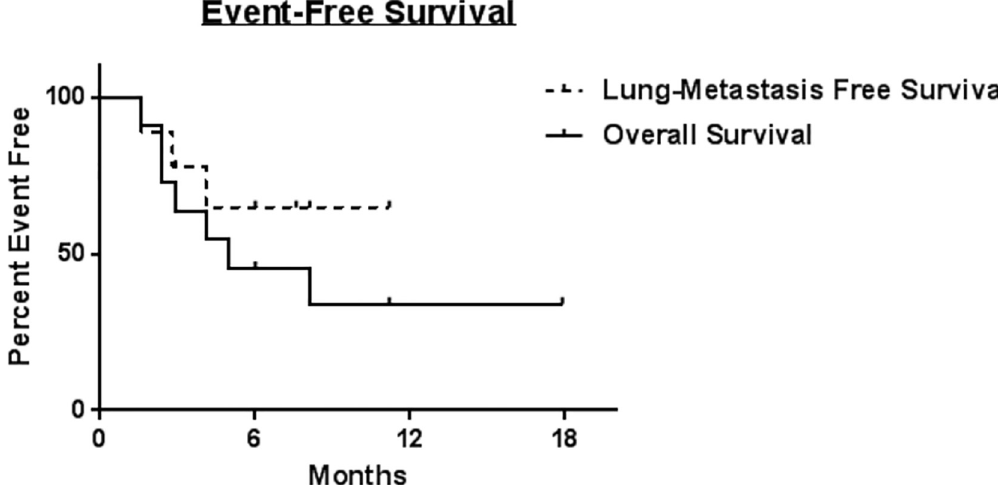
Fig 1. Kaplan-Meier analysis of updated event-free and overall survival for ten dogs on trial. Kaplan-Meier survival curves for lung-metastasis free survival (dashed line) and overall survival (solid line) for dogs with locally advanced, non-metastatic osteosarcoma treated with palliative radiotherapy and intra-tumoral NK transfer x2. Median survival was not reached for lung-metastasis free survival during the follow up